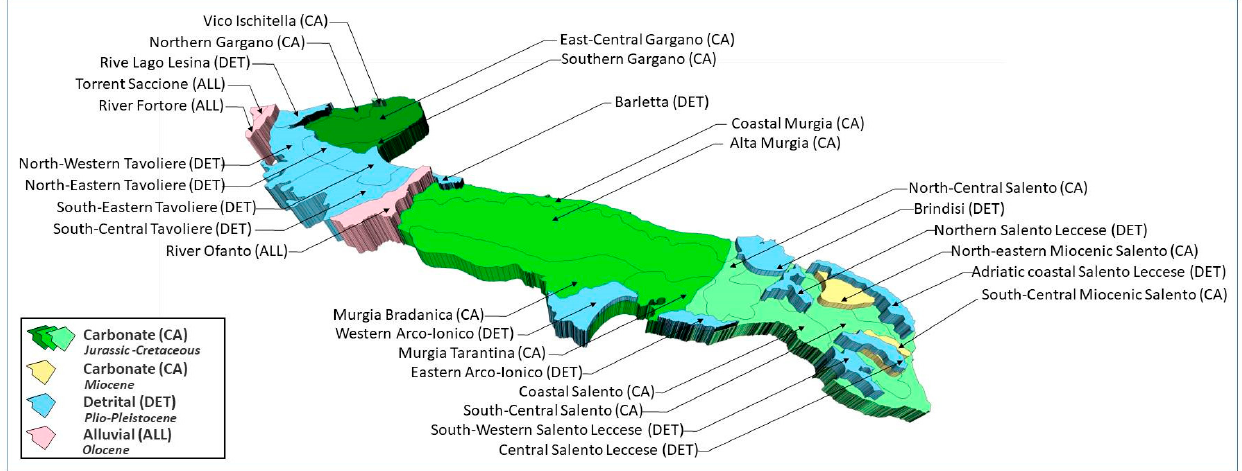
Figure 4. Sketch map showing the geographic position of Apulia GWBs.